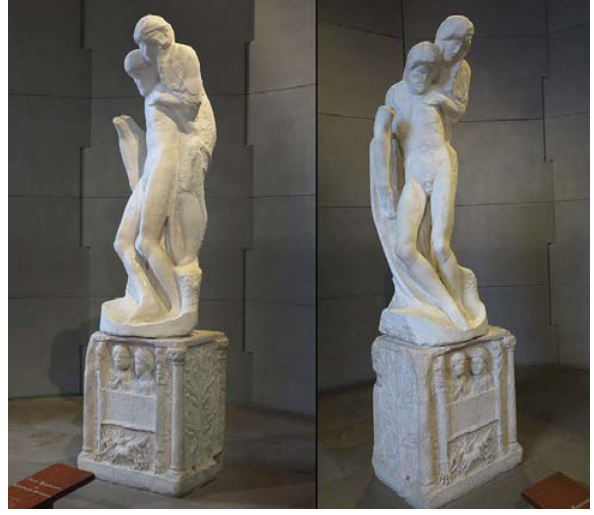
Figure 1: Pietà Rondanini statue.